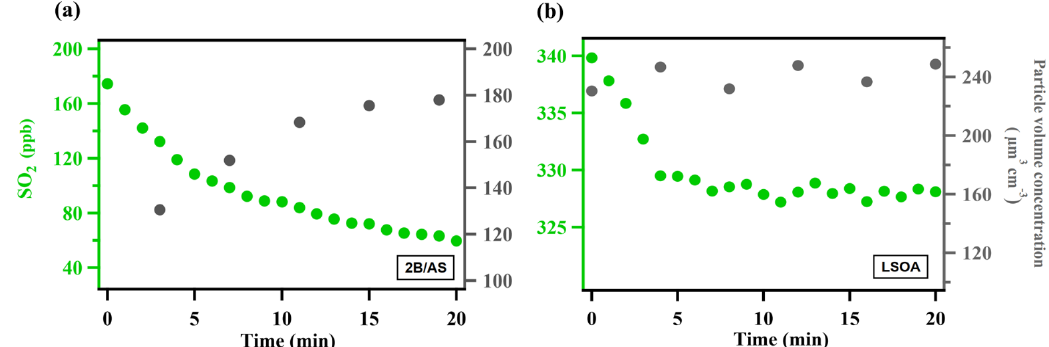
Figure 1. Typical evolution of the species monitored during γ SO peroxide (2B/AS, Expt. 16) and (b) limonene SOA (LSOA, Expt. 27). Particle volume concentrations measured by SMPS have been corrected for wall loss assuming a pseudo-first-order loss rate (Ye et al., 2016). γ SO